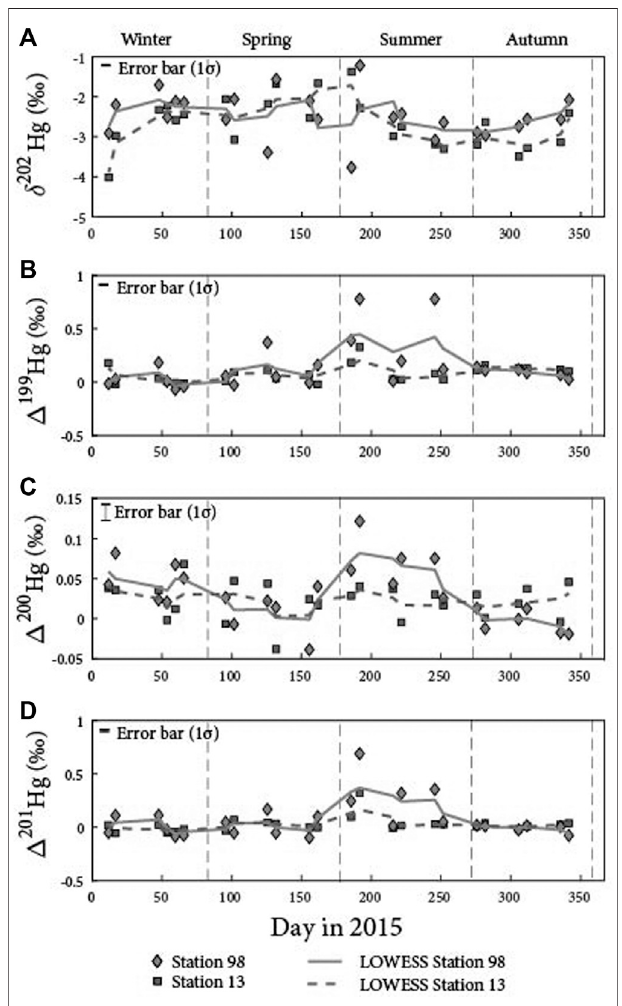
FIGURE2 | Hg multi-isotopic compositions. (A) δ 202 Hg, (B) Δ 199 Hg, (C) Δ 200 Hg and (D) Δ 201 Hg time series in aerosols sampled in Montreal. Locally weighted scatter plot smoothing (LOWESS) is also shown for all Hg isotopic